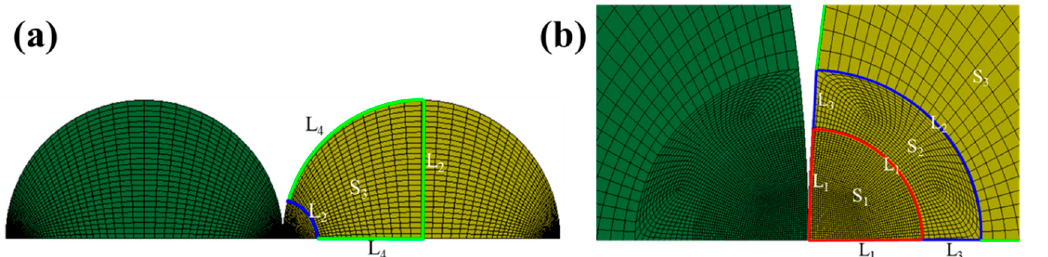
Figure 2. Finite element mesh of the granules: ( a ) meshes of two adjacent granules; ( b ) locally refined meshes in the contact areas.